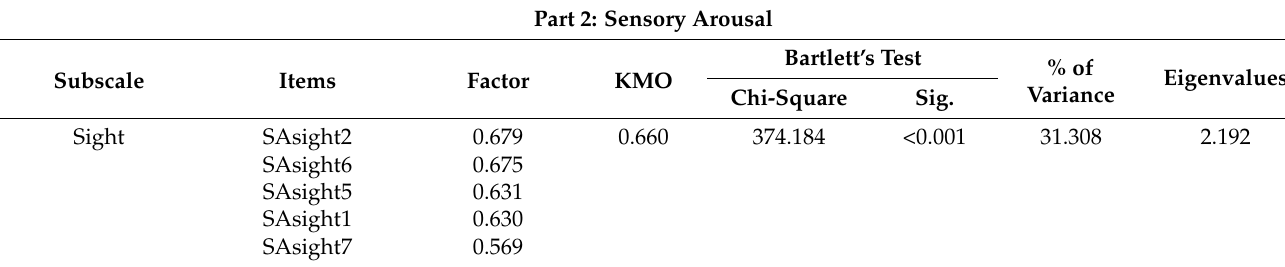
Table 3. Factor loading of sensory arousal in each modality. Part 2: Sensory